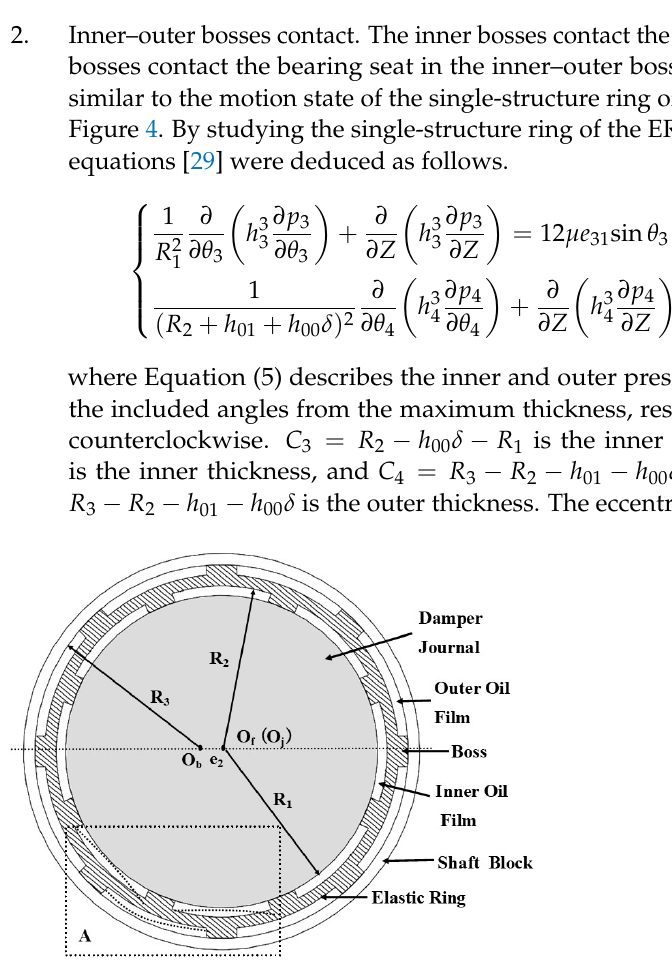
Figure 4. Inner-outer bosses